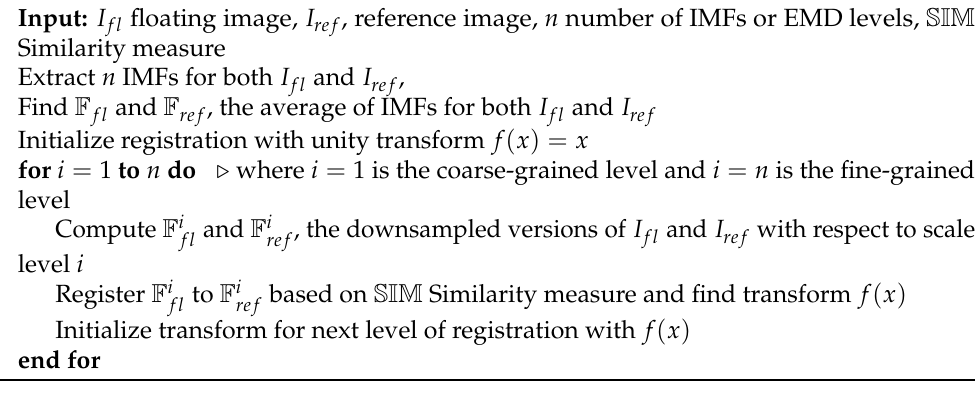
Algorithm 2 AFR-EMD: Image registration based on Average EMD